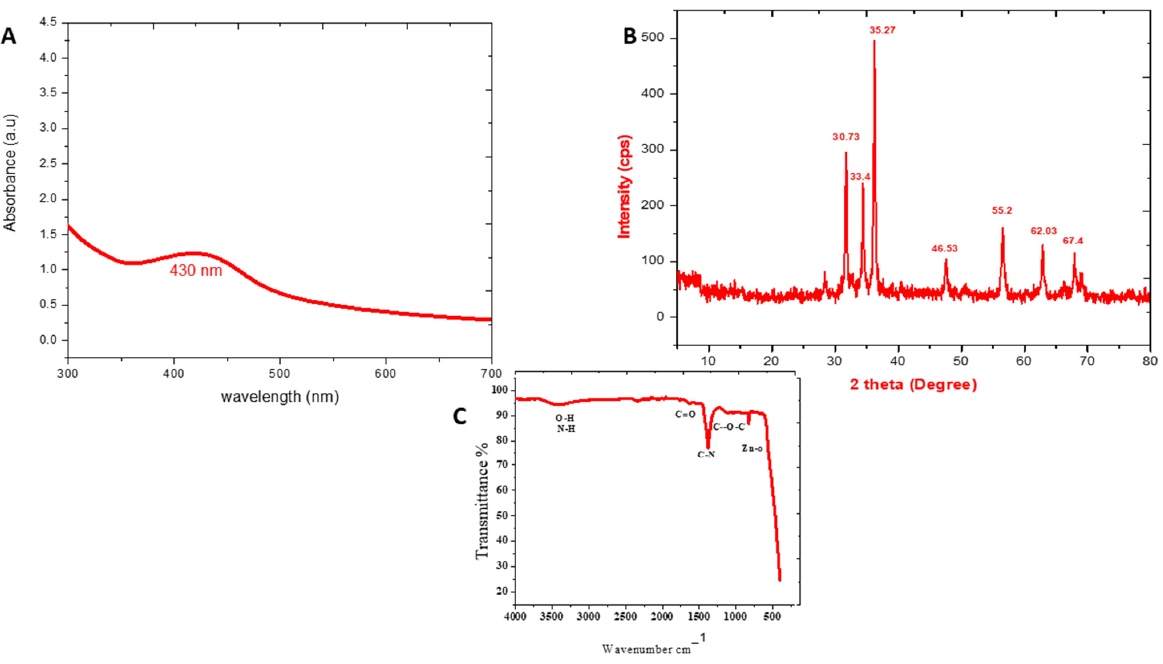
Figure 2. ( A ) UV visible spectrum. ( B ) Typical XRD pattern. ( C ) Typical FTIR spectra of Monotheca buxifolia synthesized